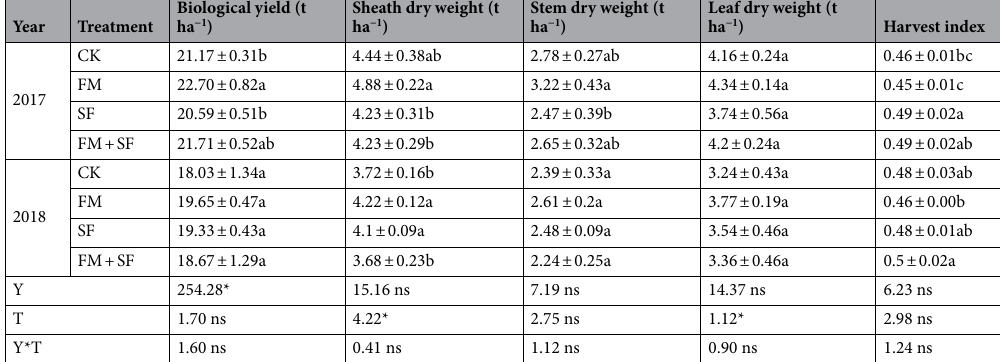
Table 4. Effects of bast fiber film and nano-silicon fertilizer treatments on dry matter allocation in rice at mature stage. Different letters indicate significant difference at 5% level. Summary of ANOVA results: not significant (ns), significant at p < 0.05 (*), very significant at p < 0.01 (**). Y Year, T Treatment.